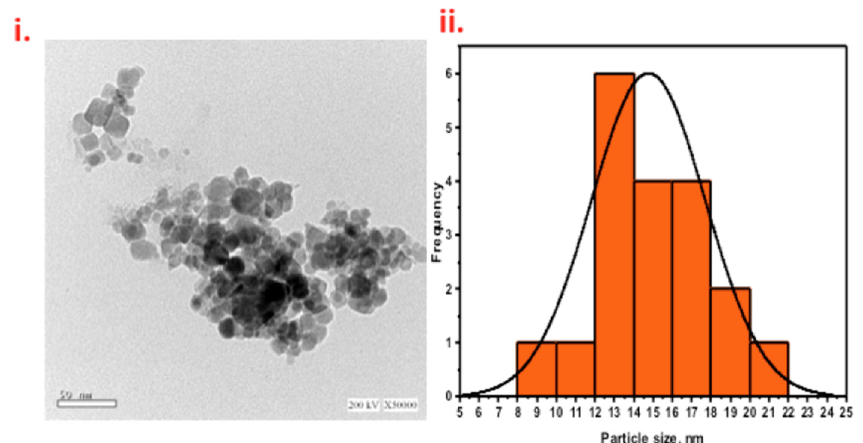
Figure 3. TEM images of WSD:Mag nanoparticle composite material ( i ) and particle size distribu- tion ( ii ).